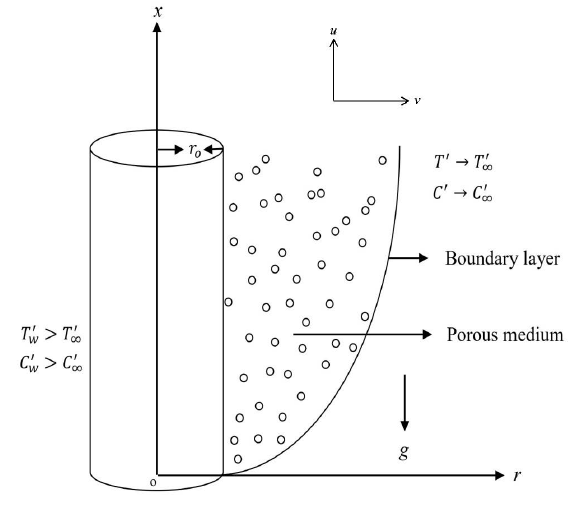
Figure 1: Schematic representation of the problem.